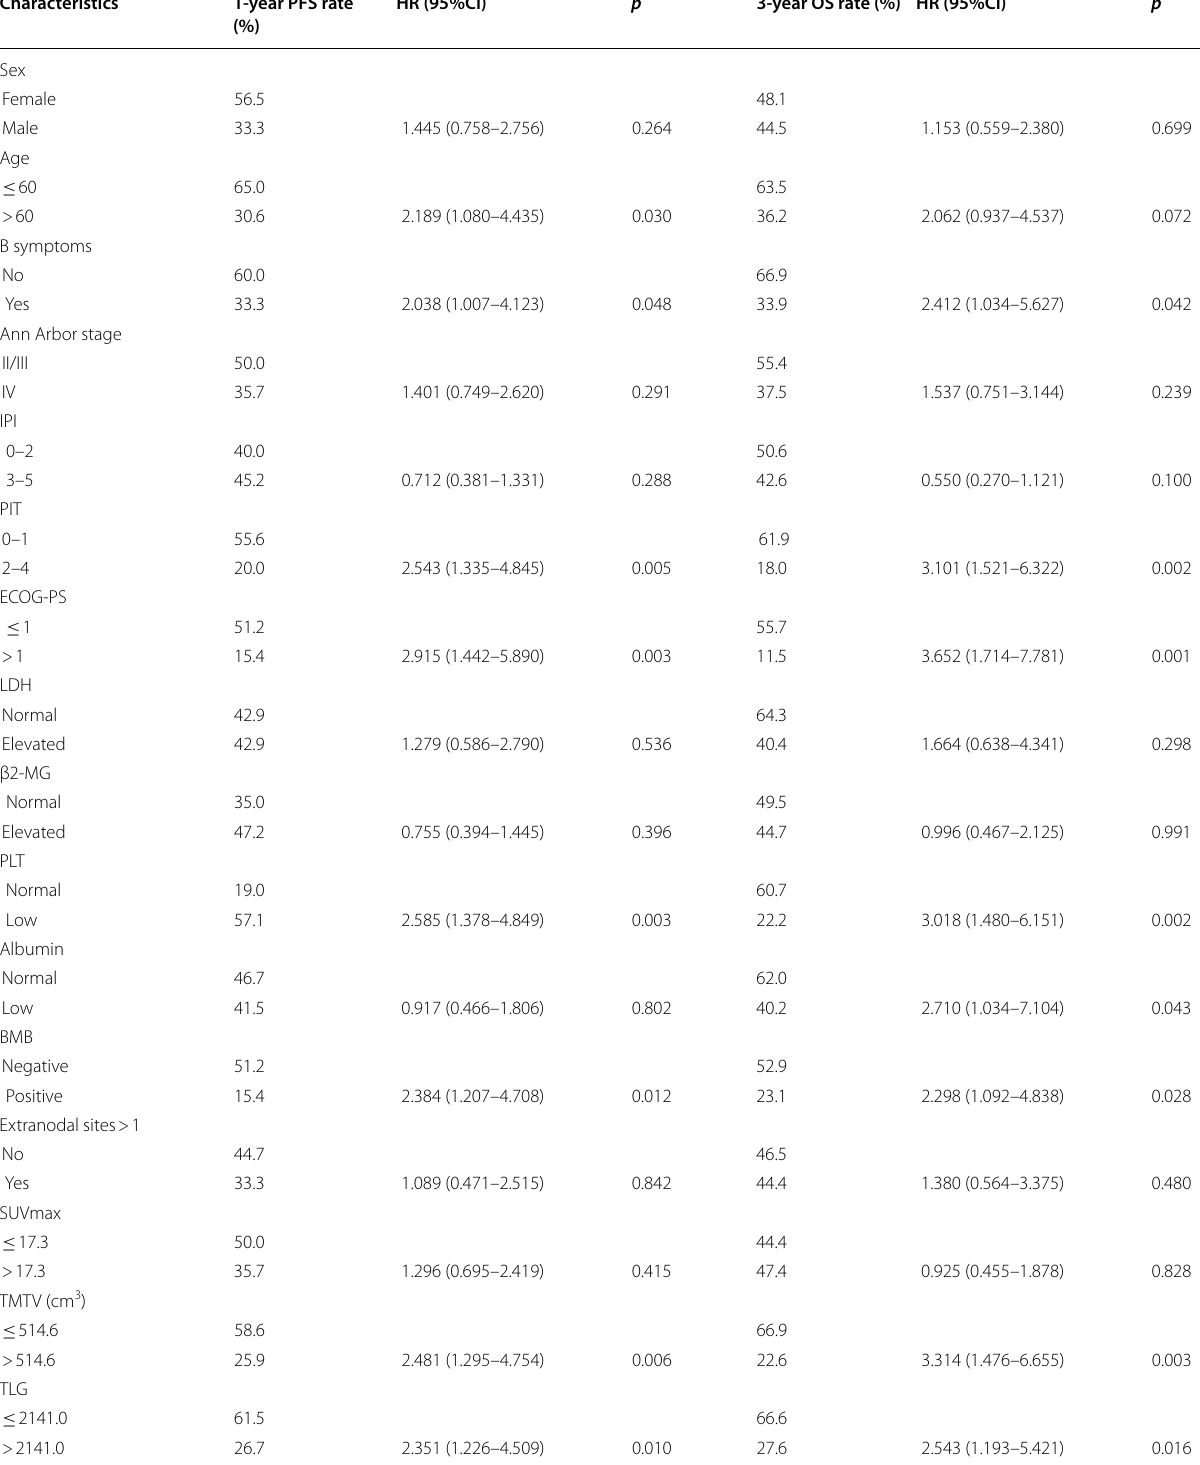
Table 3 Univariate regression survival analysis for survival and disease progression